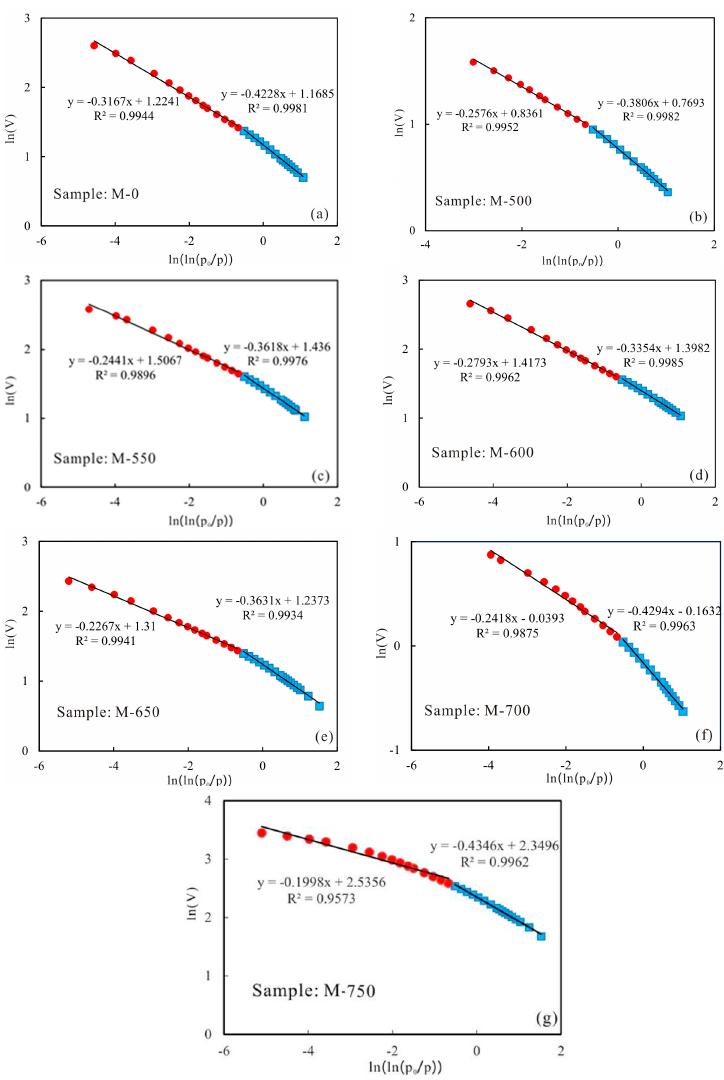
Figure 11. Plots of ln(V) vs ln(ln( P 0 / P )) reconstructed from the N 2 adsorption isotherms: ( a ) The initial sample M-0, ( b ) sample M-500, ( c ) sample M-550, ( d ) sample M-600, ( e ) sample M-650, ( f ) sample M-700, ( g ) sample